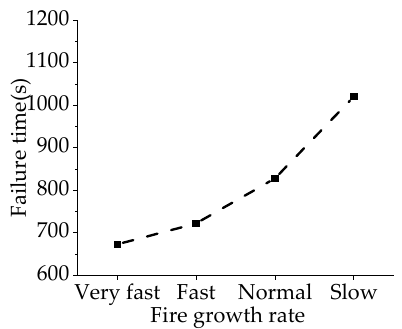
Figure 15. Time of membrane failure stage in different fire events.